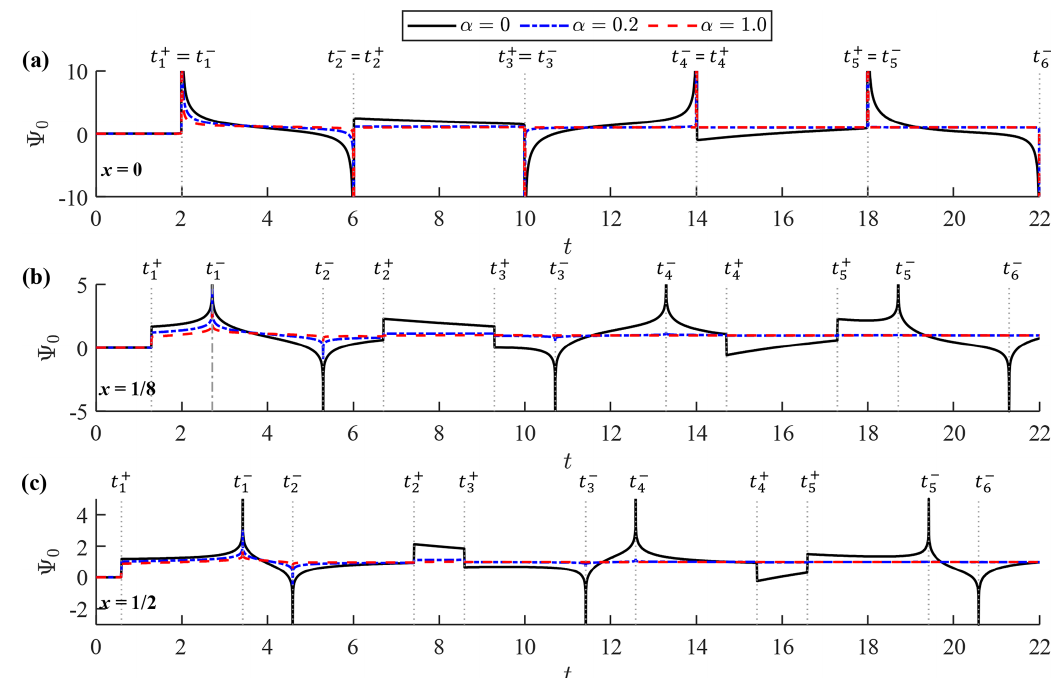
Figure 3. Function (cid:57) 0 (x,t) at (a) x = 0, (b) x = 1 / 8 and (c) x = 1 / 2. Each panel shows graphs of the function for α = 0, α = 0 . 2 and α = 1 . 0. Vertical dotted lines represent the timing of singularities, t ± m .